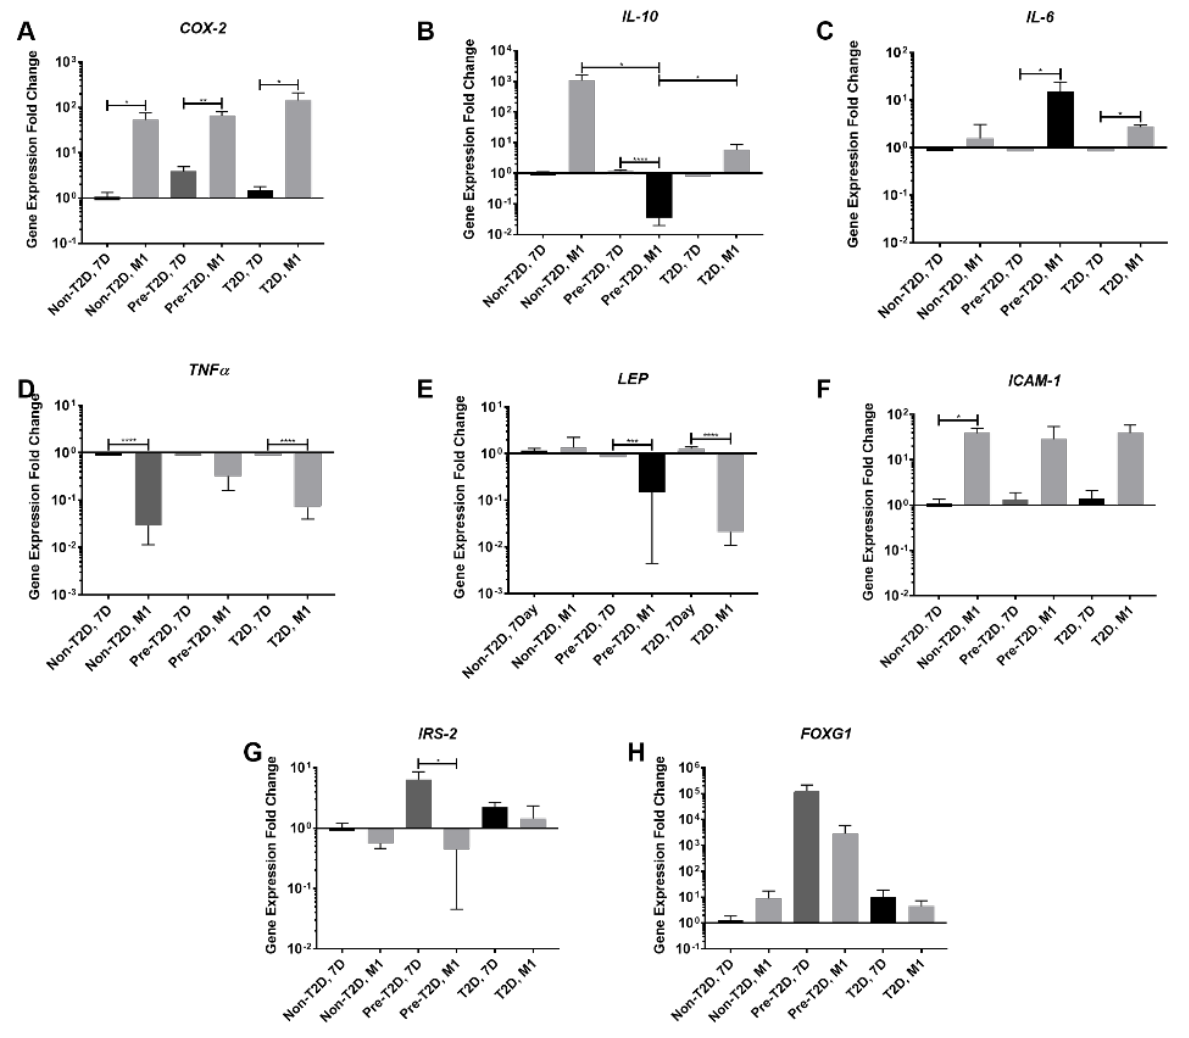
Figure 6. Increased IL-6 and Cox-2 expression by Pre-T2D and T2D IPFP-ASCs after co-culture with M1 Macrophages. ( A – H ) IPFP-ASC mRNA expression determined by RT-PCR ( n = 3, * p < 0.05, ** p < 0.01, *** p < 0.001, **** p < 0.0001). Reference Group: Non-T2D, 7 Day. Non-T2D: Non-Type II dia- betes mellitus, Pre-T2D: Pre-Type II diabetes mellitus, T2D: Type II diabetes mellitus.